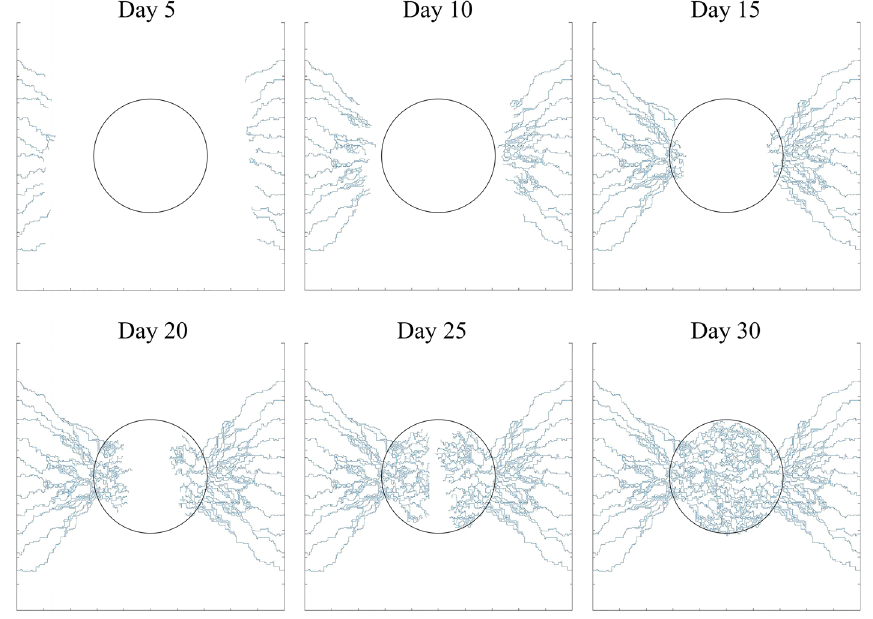
Figure 5. Different stages of microvascular network formation during angiogenesis at days 5, 10, 15, 20, 25, and 30.